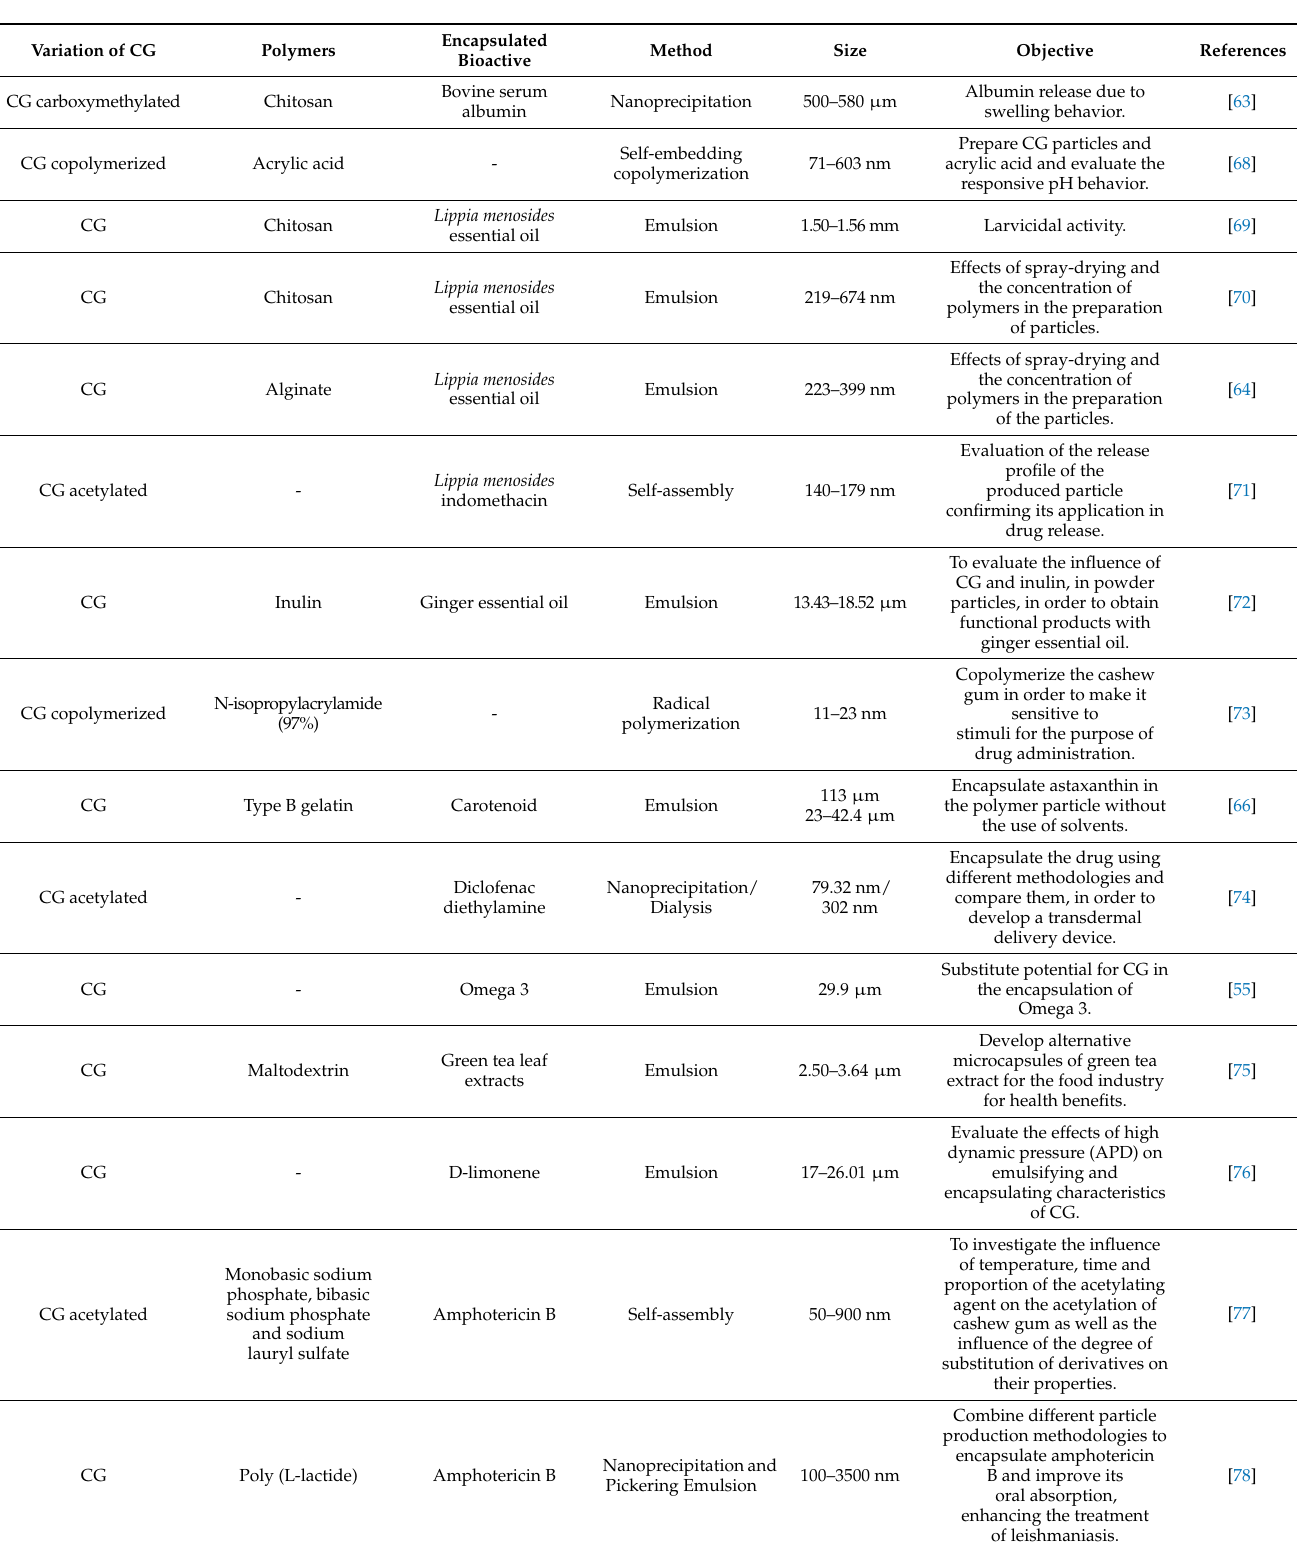
Table 2. Applications of cashew gum (CG) for the loading of bioactives in the production of